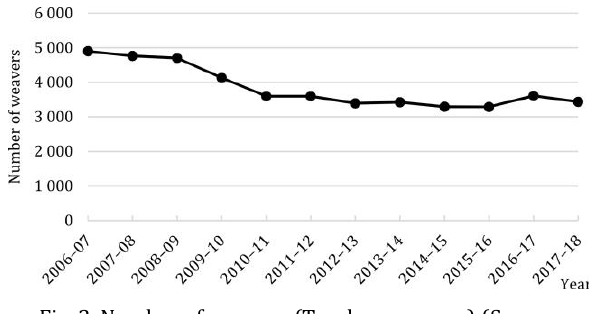
Fig. 2. Number of weavers (Tarakeswar zone) (Source: Handloom Development Office, Chinsurah, 2018)